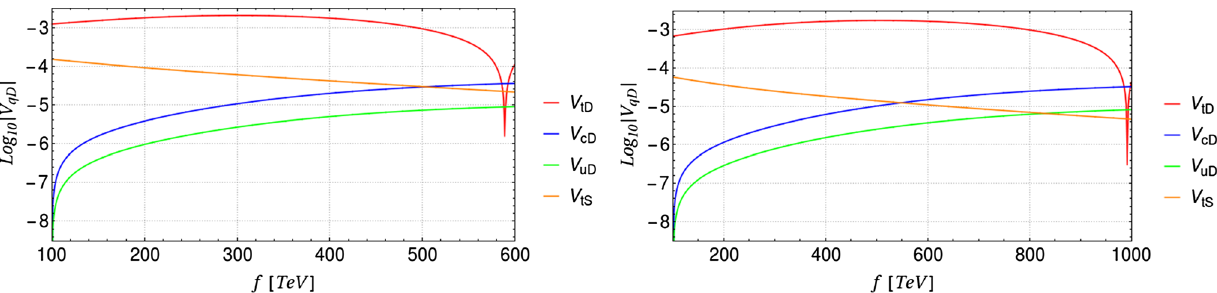
Fig. 3 The four largest quark mixing elements between VLQs and up-type SM-like quarks. In these plots s = ω = 100 TeV. On the left panel p = 600 TeV and on the right panel p = 1000 TeV. The f -scale varies between the limiting ω – f and the p – f compressed scenarios